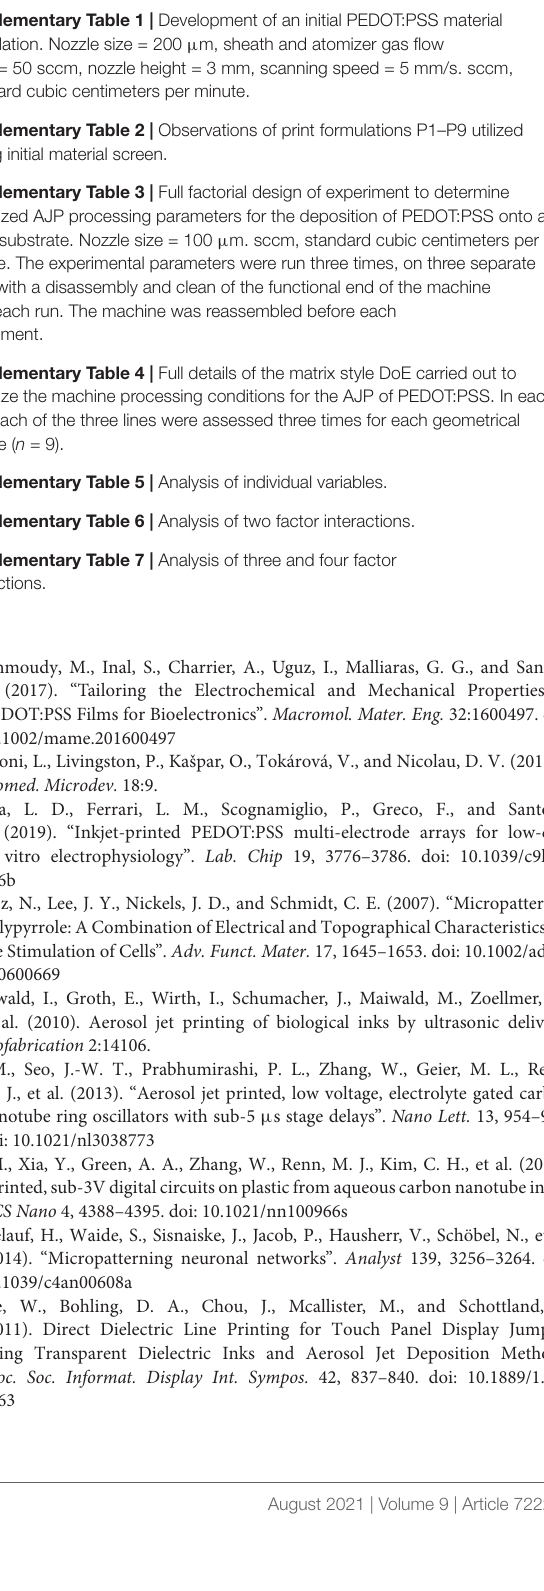
Supplementary Figure 2 | Representative microscopic image of print formulation P4 (Scale bar = 200 µ m). Supplementary Figure 3 | White light interferometry measurements of maximum height vs. cross sectional area for PEDOT:PSS tracks printed onto a glass substrate via AJP. Supplementary Table 1 | Development of an initial PEDOT:PSS material formulation. Nozzle size = 200 µ m, sheath and atomizer gas flow